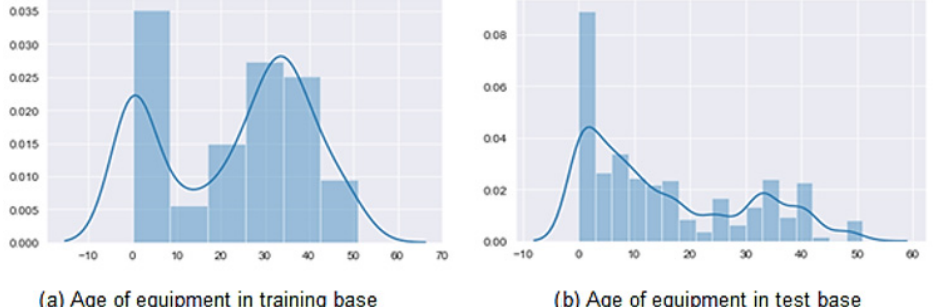
Figure 16. Age of equipment in the training and test bases for the RUT 340 [authors].